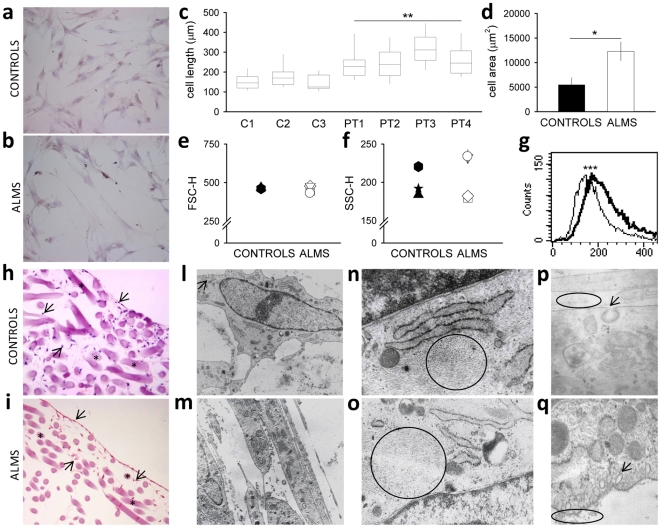
Size, shape and ultrastructural evaluation of ALMS fibroblasts.(a) Fibroblasts of healthy control (C3) and (b) ALMS patient (PT3) were grown on standard tissue culture (2D cultures) coverslips and stained with hematoxylin-eosin (magnification 20×). (c) Cell length of about 40 fibroblasts per subject was quantified by measuring the longitudinal cell length and was plotted as mean (horizontal line), maximal and minimal length values (vertical line). **P<0.01 ALMS fibroblast length mean versus controls length mean. (d) The area covered by fibroblast cells during exponential growth was estimated by cell counting in Bürker chambers, after 0.2% trypan blue staining. Results are reported as mean ± SEM. *P<0.05. ALMS fibroblasts were compared with controls by flow cytometric analysis: (e) the resulting forward (FSC) and (f) side light scatter (SSC) mean intensity values are shown for each subject. Controls: C1, black triangle; C2, black star; C3, black diamond; Patients: PT1, white circle; PT2, white square; PT3, white triangle; PT4, white diamond (see also Table 1). Panel g reports the SSC distribution of fibroblasts from C1 (black line) and PT1 (grey line) showing the highly significant shift (***P<0.001, as determined by the Kolmogorov-Smirnov analysis according to the Macintosh CELLQuest software user's guide, Becton Dickinson). (h) Fibroblasts of healthy control (C2) and (i) ALMS patient (PT2) were cultured in HYAFF-11™ scaffolds (3D-cultures) and stained with hematoxylin-eosin (magnification 5×; * biomaterial scaffolds; → fibroblast cells). Transmission electron microscopy was performed in healthy control (C2) (l–n–p) and ALMS patient (PT2) (m–o–q) on 3D-cultured cells. Control fibroblasts showed a normal phenotype, with typical bipolar morphology (l), cytoplasm rich in perpendicular oriented microfilaments (n, ring), the presence of normal pinocytic vesicles (l arrow and p) and probably collagen fibers in the extracellular space (p, ring). In contrast, ALMS fibroblasts appeared as elongated cells tightly adherent to each other and showed well-defined long cytoplasmic extensions (m). Microfilaments (o, ring) were arranged in a unique direction, parallel to the long axis of the cells. A large amount of exocytic vesicles and probably collagen fibrils (q, arrow and ring, respectively) suggest active secretion. Magnification: l–m = 5000×; n–o = 25000×; p = 40000×; q = 30000× (see also Figure S3 and S4).